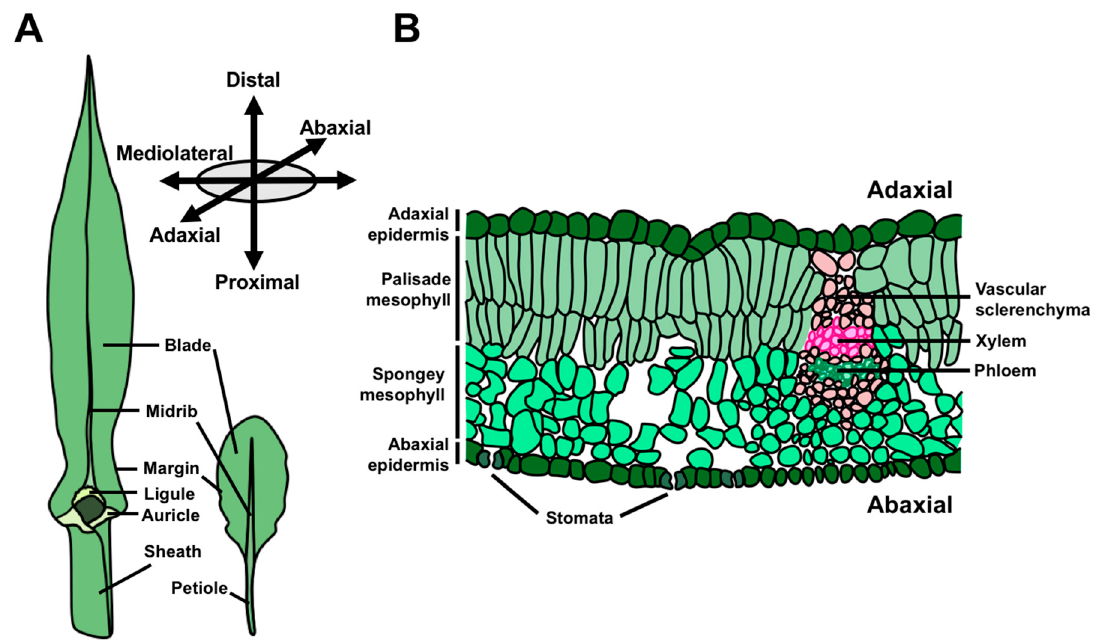
Figure 1. Leaf anatomy and growth axes. ( A ) Leaves from maize, a monocot, and the two closely related eudicots, Cardamine hirsuta and Arabidopsis thaliana , highlighting major features of leaf anatomy. ( B ) Cross-section of a mature eudicot leaf illustrating the characteristic features of the adaxial and abaxial leaf domains.